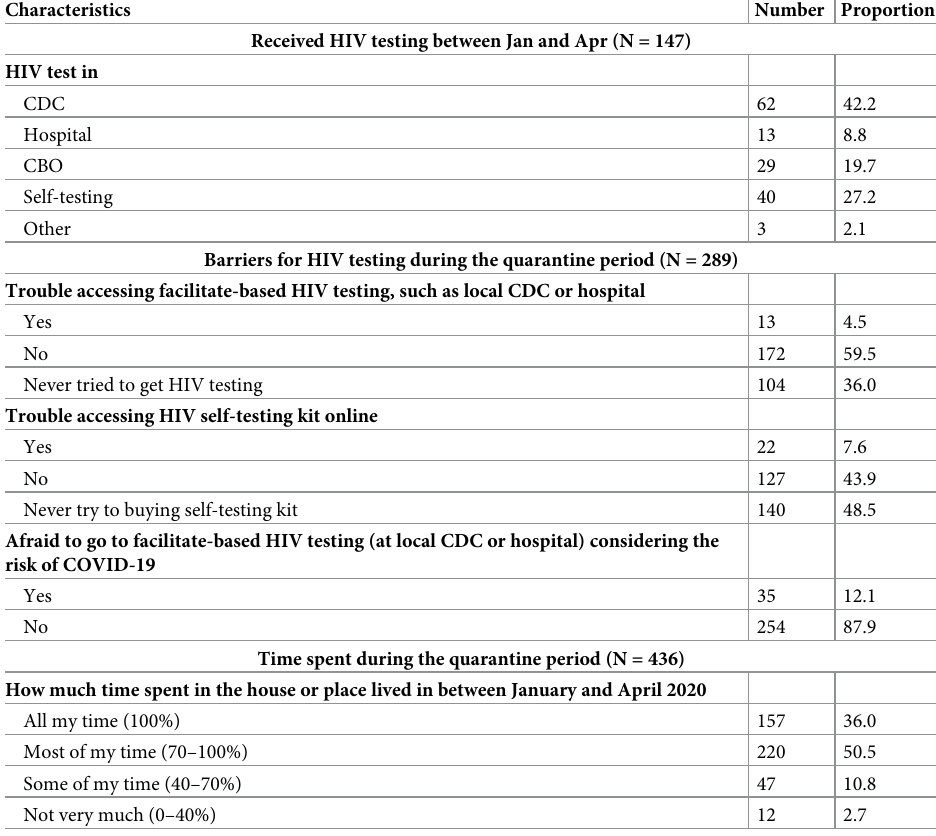
Table 1. Locations, barriers for HIV testing during COVID-19 among MSM in Jiangsu Province, China.